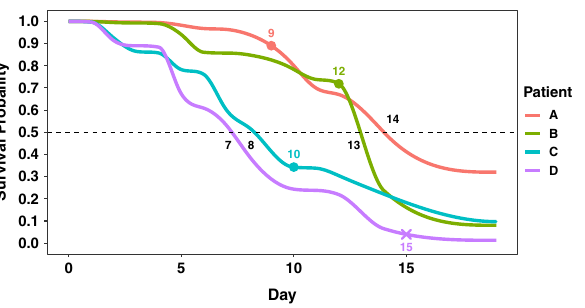
Figure 1. Individual survival distributions of mortality of four patients, computed by the MTLR. We use a solid “ • ” to show when each patient actually died (for patients A , B , C ), and an “ × ” for the time when a patient was censored (here D